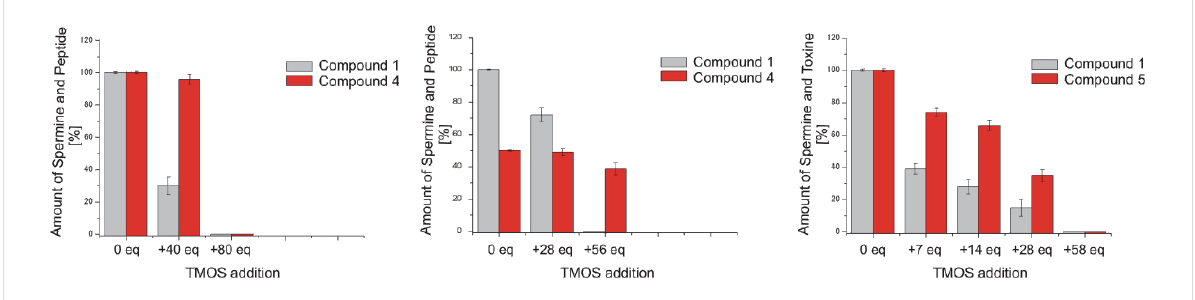
Figure 6: Silica precipitation competition experiments. Experimental details are according to the single component precipitations in Table 1. The addi- tion of TMOS is shown on the x -coordinate and the starting conditions are set to 100% for better comparison. The left diagram shows spermine ( 1 ) vs R 5 peptide 4 in a 1:1 ratio (10 μ mol/mL each) and the middle diagram shows them in a 2:1 ratio (15 μ mol/mL both). In both precipitation experiments, 1 is consumed before a relevant amount of 4 precipitates. Right: 1 vs 5 in a 1:1 ratio (5 μ mol/mL each). Again, 1 is the better precipitator although both organic molecules are consumed during the mineralization process.